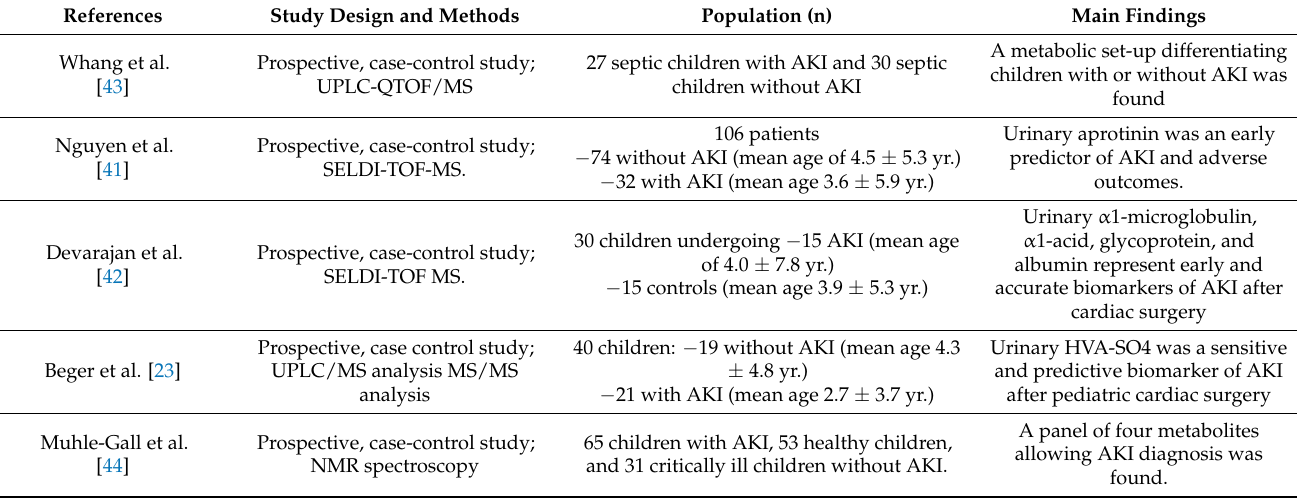
Table 1. Main findings of omics studies in children with